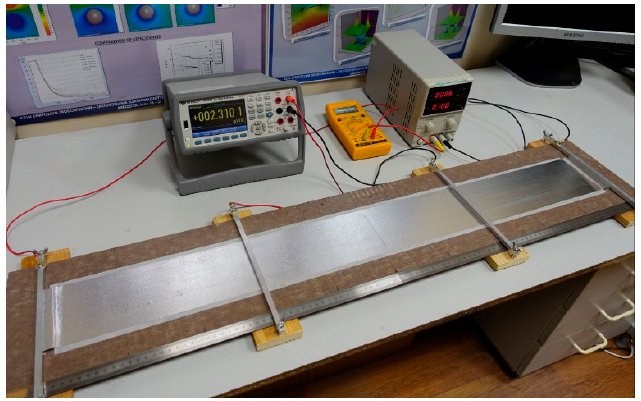
Figure 10. Resistance measurement system for a path with a defect (crack in the middle of the path).